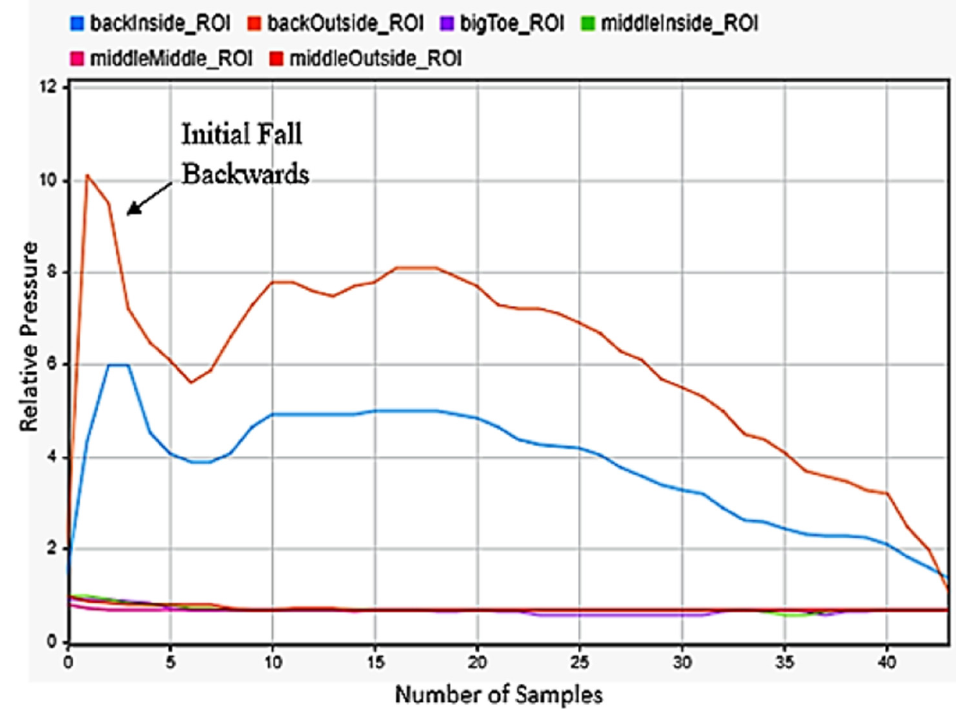
Figure 13. Falling backwards sensor data for the left foot.